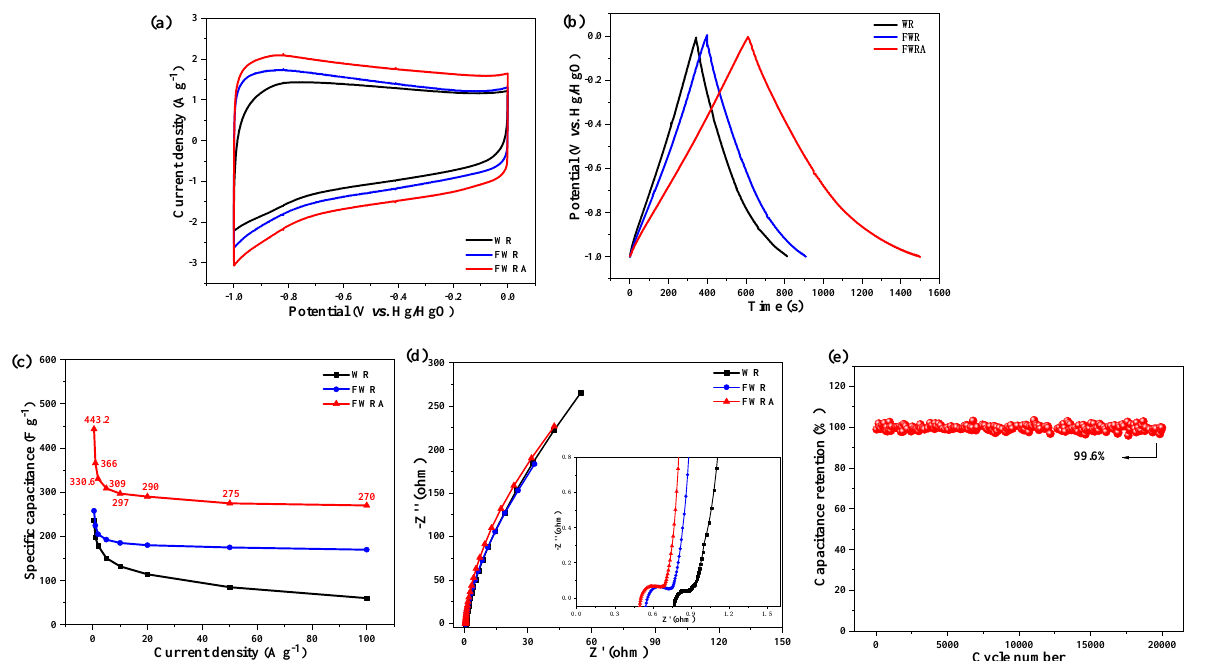
Figure 4. Electrochemical performances of the WR, FWR and FWRA electrodes tested in 6 M KOH electrolyte: ( a ) CV curves at a scan rate of 10 mV s − 1 ; ( b ) GCD curves at a current density of 1.0 A g − 1 ; ( c ) specific capacitance versus current density; ( d ) Nyquist plots of the electrodes fabricated based on WR, FWR and FWRA and the inset is the magnified image of high-frequency region; ( e ) Cycling stability at a current density of 5 A g − 1 for the FWRA sample.